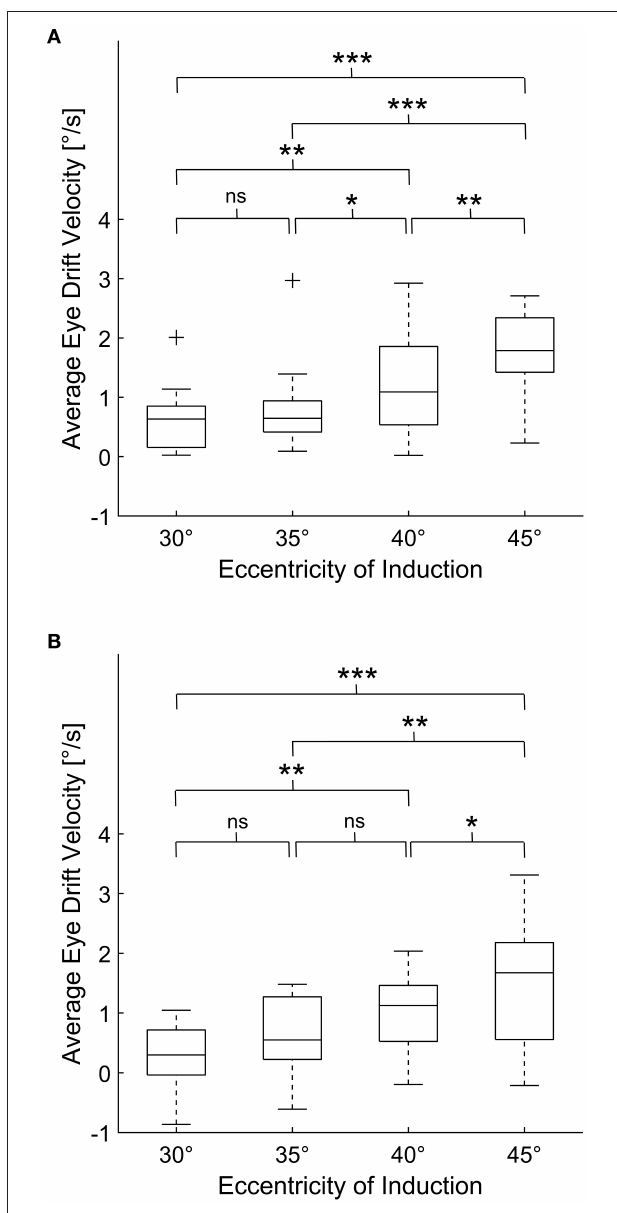
FIGURE 2 | Average eye drift velocities of all subjects during 30s of eccentric gaze (A) and after subsequent return to primary position (B) . For each box, the central line indicates the median value. The bottom and top of the box indicate the 25th and 75th percentiles, while the whiskers extend to the most extreme data points that are not considered outliers. The outliers are marked with “ + .” One-way repeated measures ANOVA demonstrated statistically significant changes in eye drift velocity depending on the eccentricity of the induction phase for both eye drift during and after 30s of eccentric gaze. The p -values, corrected for multiple comparison using Bonferroni adjustment, are shown in each panel (ns for p > 0.05, * for p ≤ 0.05, ** for p ≤ 0.01, *** for p ≤ 0.001).